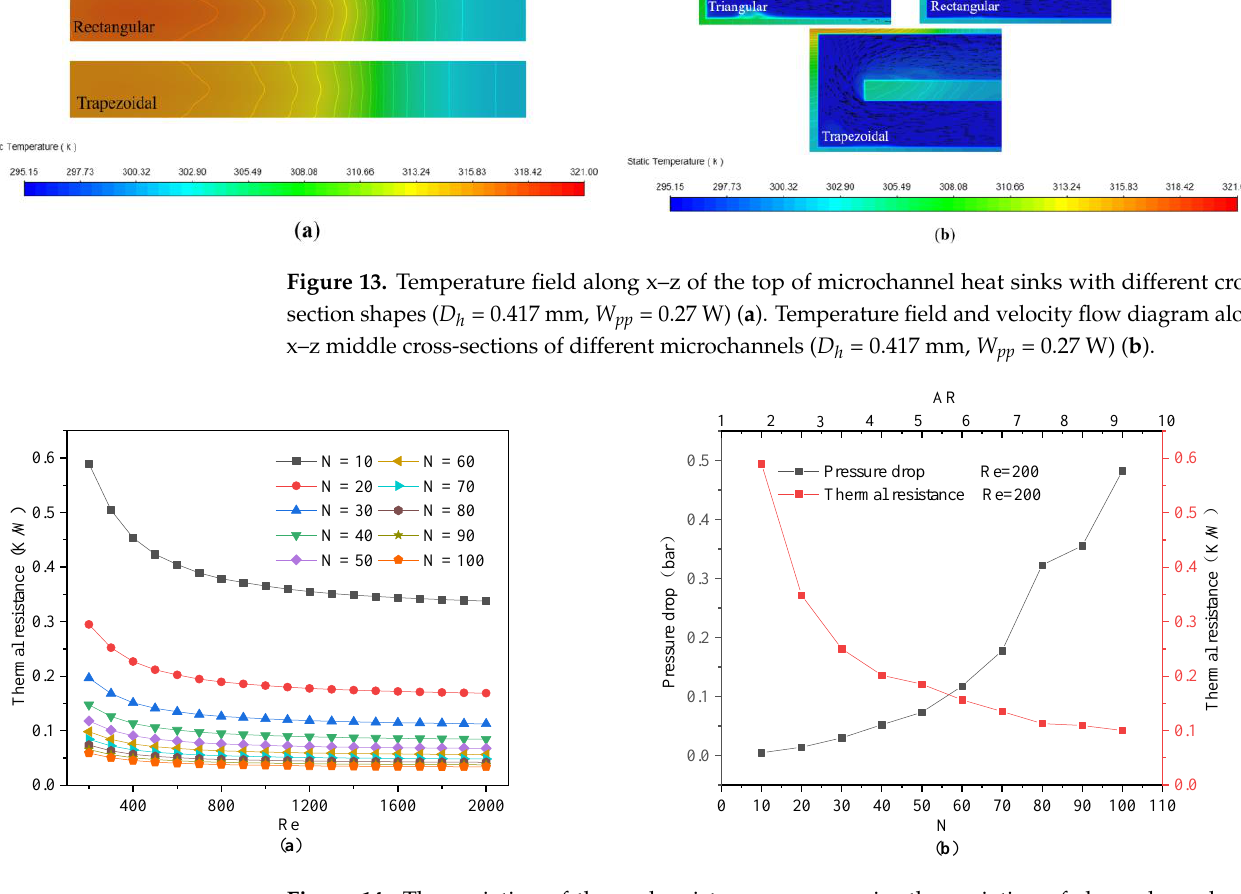
Figure 14. The variation of thermal resistance accompanies the variation of channel number at different Reynolds numbers ( a ). The variation of thermal resistance and pressure drop with change in number of channels at the same Reynolds number ( b ).